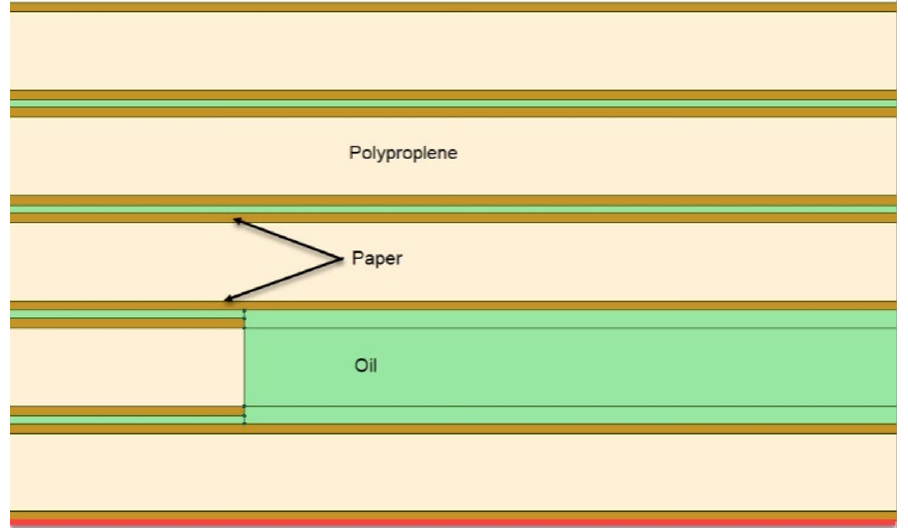
Figure 2. Fragment of the geometric model of laminated insulation in the longitudinal section. The bottom layer of the paper is in contact with the conductive core; thus, the potential at the lower boundary is equal to the phase voltage. The potential on the upper bound of the modeled fragment is slightly different for zones 1, 2, and 3. Its average value for a zone (Figure 3) can be easily extracted from the field pattern in the cross-section (Figure 1). The axisymmetric model of insulation in zones 1, 2, and 3 differs both in the value of the potential at the upper boundary and in the radius of the inner layer, which